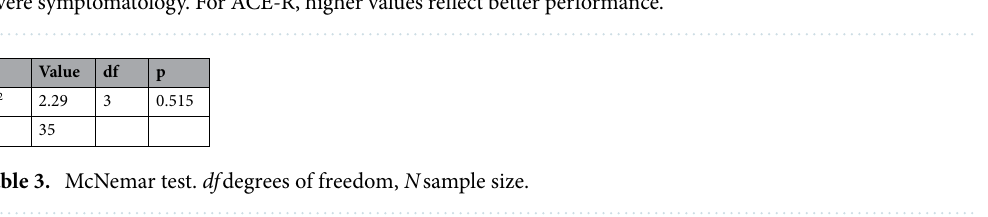
Figure 1. Considering assessments before and during the pandemic, ( a ) the upper part of the figure shows mood changes in terms of apathy (AES, Apathy Evaluation Scale) and anxiety (HARS, Hamilton Rating Scale for Anxiety), and ( b ) the bottom part of the figure shows global cognitive performance on ACE-R (Addenbrooke’s Cognitive Examination—Revised version). For AES and HARS, higher values reflect a more severe symptomatology. For ACE-R, higher values reflect better performance.